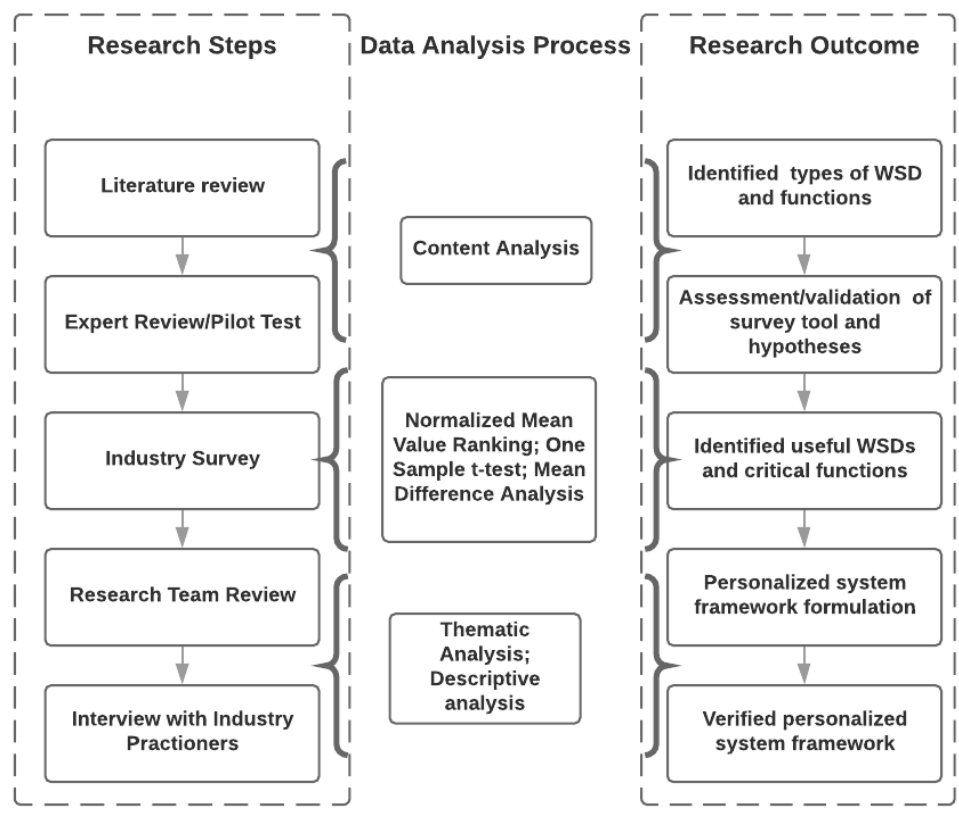
Figure 1. Research process and framework.